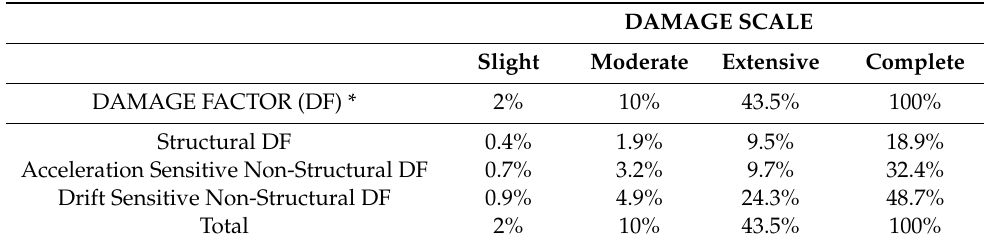
Table 4. Damage Factor Values for Schools and Libraries (HAZUS-MH